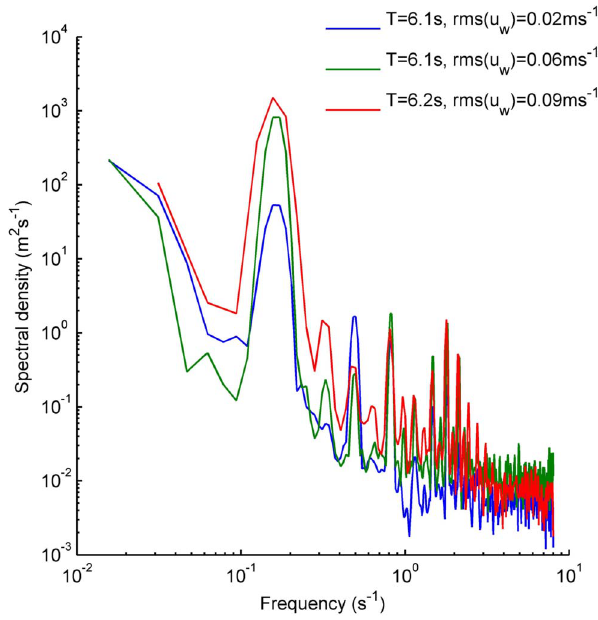
Figure 3. Example spectral density plots. Spectral density plots calculated from vertical velocity components representative from each of the rms( u w ) categories: LOW [ , 0.03 m s 2 1 , blue], MEDIUM [ . 0.03 , 0.06 m s 2 1 , green], HIGH [ . 0.06 m s 2 1 , red]